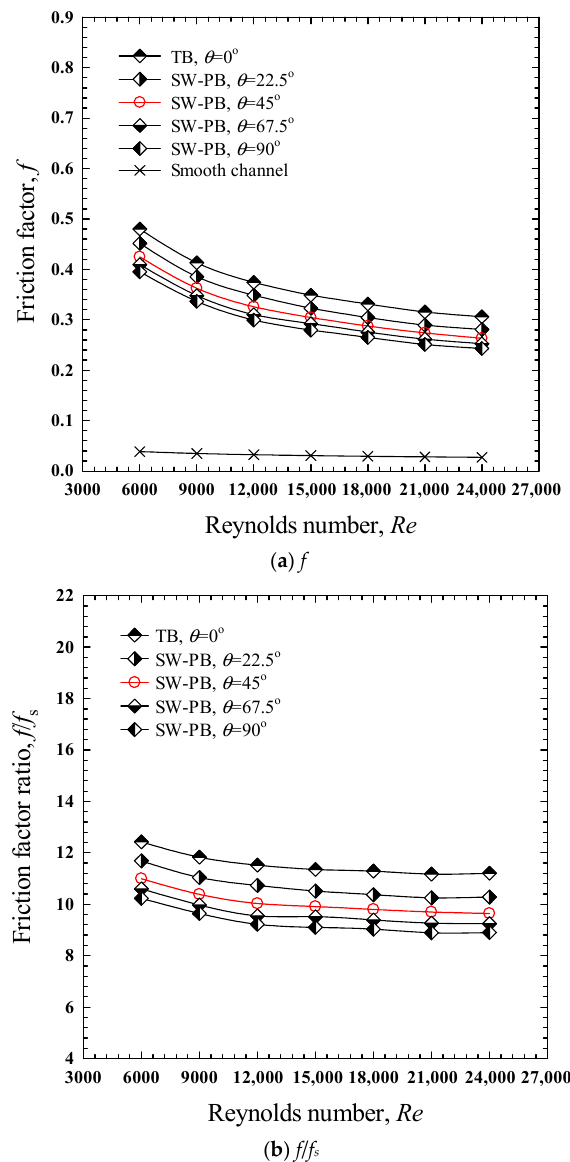
Figure 7. Friction factor ( f ) and friction factor ratio ( f / f s ) of a channel with square-winged transverse baffles (SW-TB).